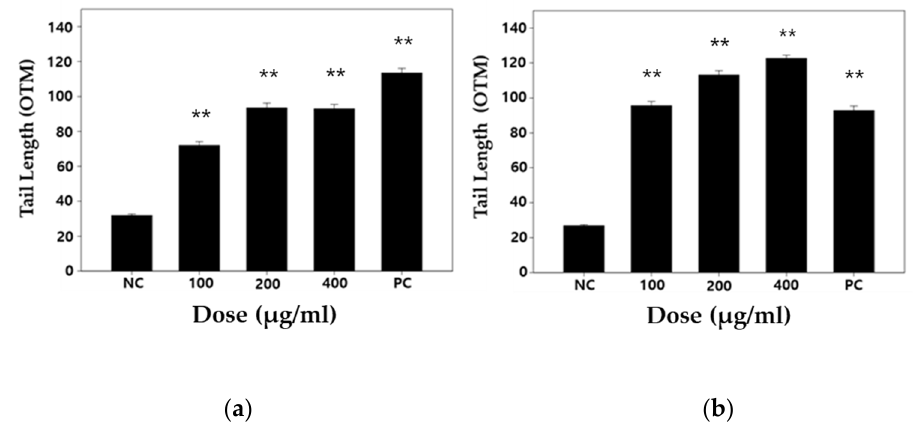
Figure 4. Quantitative assessment of DNA damage in the diesel exhaust particles (DEP) treatment of the human lung embryo fibroblast (WI-38) cells using single-cell gel electrophoresis (comet assay). The slides were stained with SYBR green and analyzed using a fluorescent microscope and image program. ( a ) The 24 h treatment group; ( b ) the 48 h treatment group. A statistically significant difference is indicated by ** p < 0.01 when compared with the negative control. Values are means of triplicate measurements. NC: negative control (0.2% DMSO); PC: positive control (0.4 µg/mL mitomycin C).